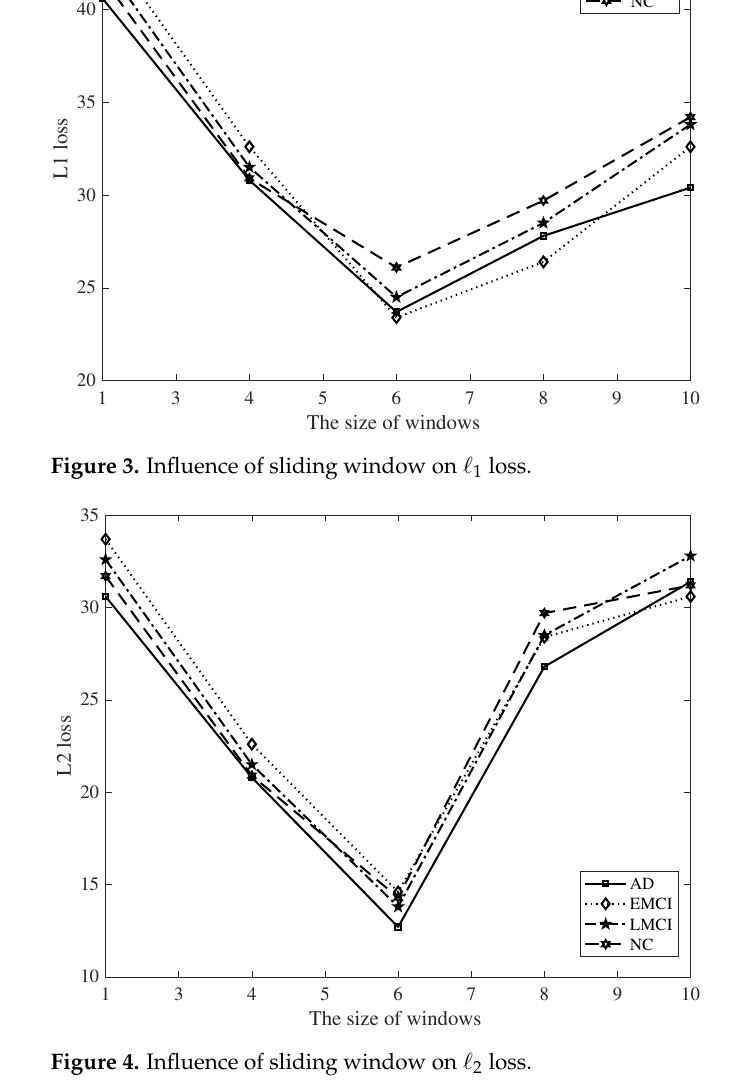
Figure 4. Influence of sliding window on (cid:96) 2